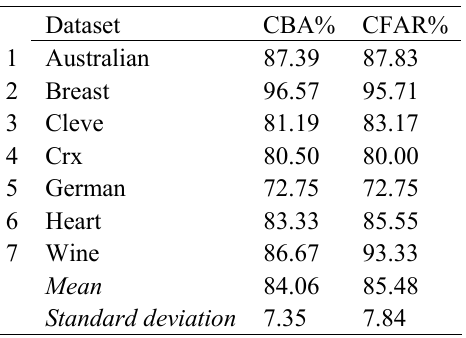
Table 11: Algorithms’ accuracy on CBA and CFAR Dataset